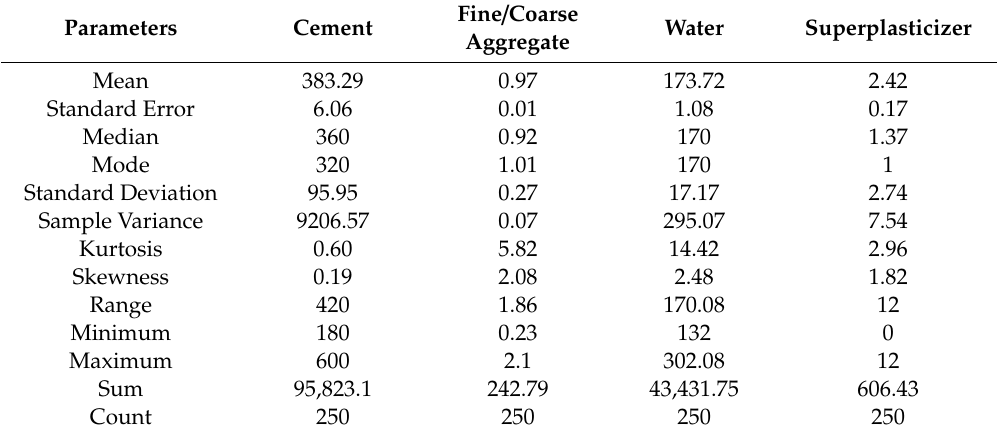
Table 3. Statistical description of training data points used in the model (Kg / m 3 ).